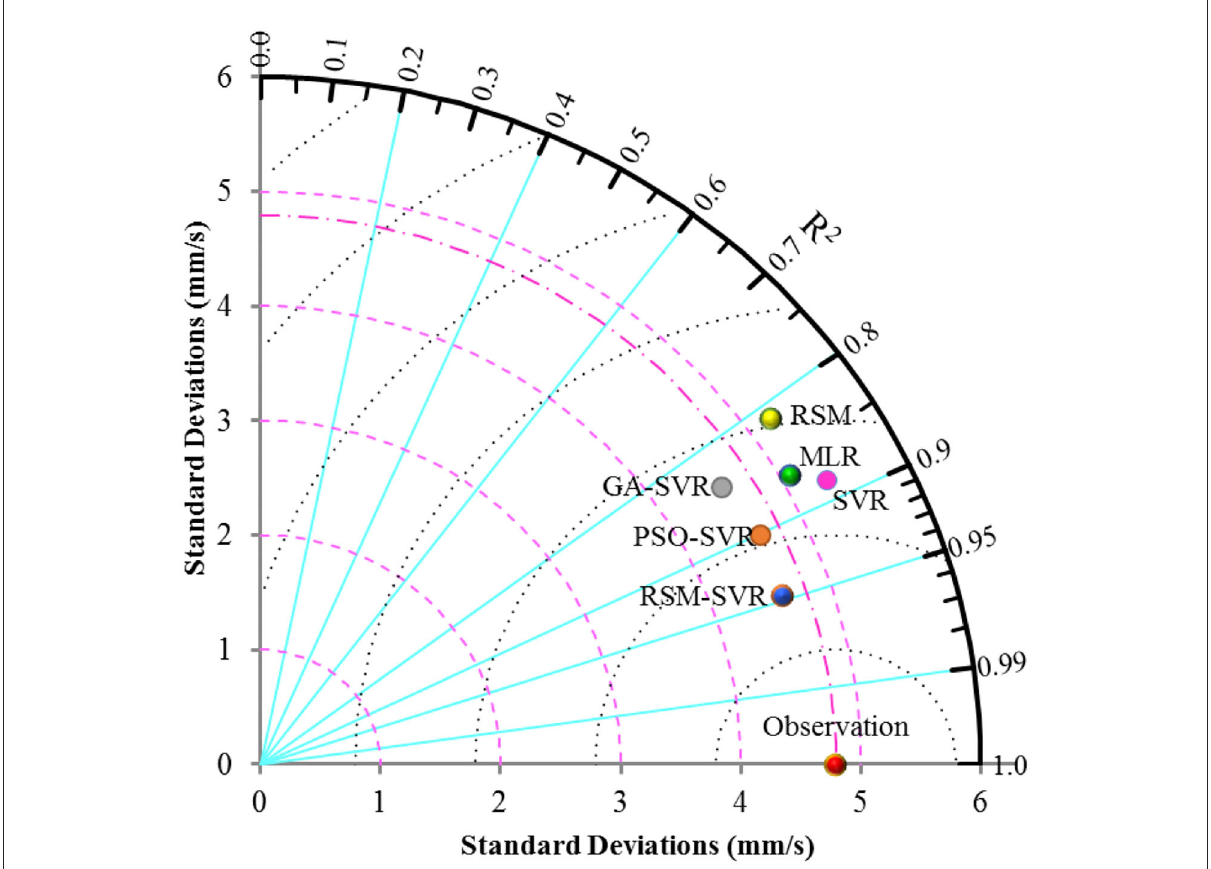
FIGURE6 Taylor diagram for different models in the testing